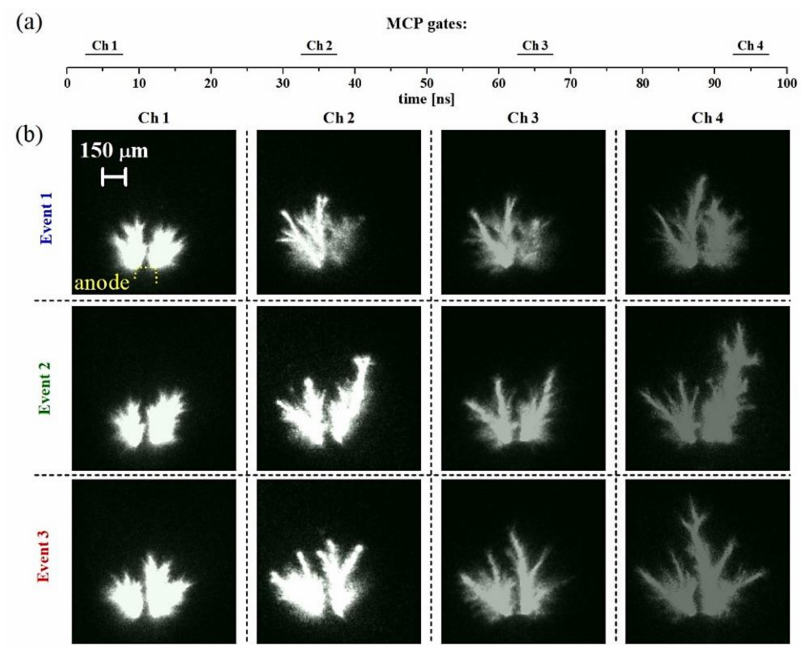
Figure 11. Case study C; image sequences obtained using broadband discharge emission. Horizontal bars in ( a ) labelled as Ch1–Ch4 illustrate the timing of the Ch1–Ch4 MCP gates with respect to the onset (time t = 0 ns) of the HV pulse. Images in panel ( b ) show the evolution of selected events during the primary and first three reflected HV pulses acquired by using equal Ch1–Ch4 MCP gates of 5